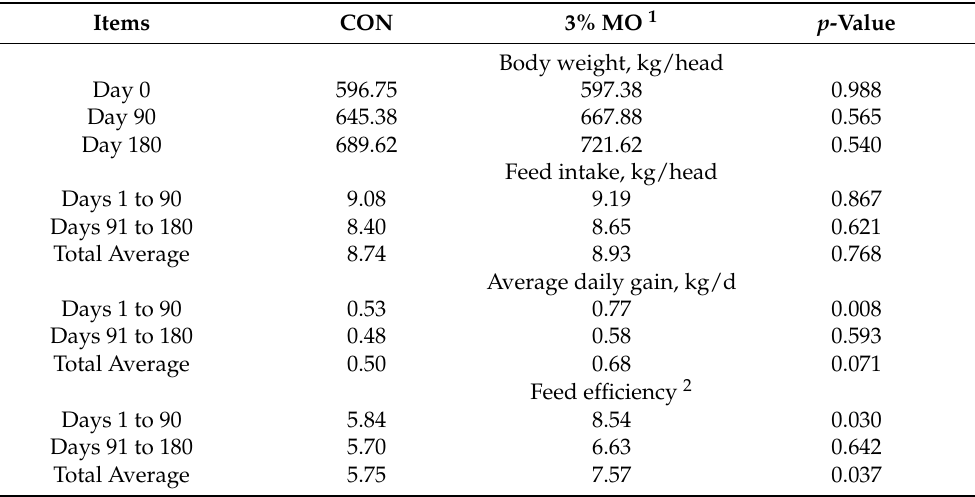
Table 4. Effect of 3% rumen-protected microencapsulated supplement (MO) on growth performance in